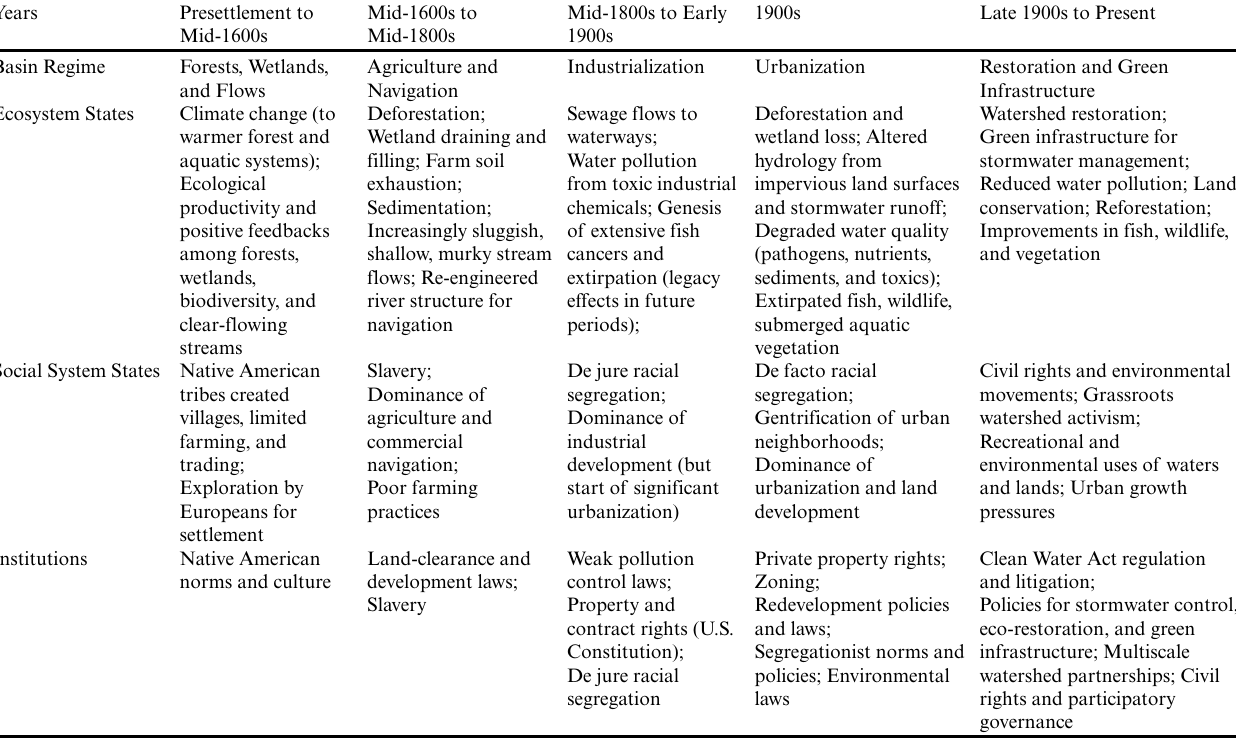
Table 3 . Social-ecological regimes in the Anacostia River Basin. A small watershed in the humid urban-suburban areas of Washington, D.C. and Maryland, the Anacostia River basin has transitioned from biologically rich natural ecology prior to European settlement to three periods of ecosystem degradation due to agriculture and navigation, industrialization, and urbanization, to the present regime dominated by restoration and green infrastructure activities, yet still influenced by previous regimes’ legacy effects and continued urban- development pressures. The major drivers of regime shifts from presettlement to the present are the following: (1) societal treatment of the basin’s waters, lands, vegetation, and wildlife as exploitable goods and services for short-term economic benefit (even in the current “green” regime in which improved water quality and restored lands are public goods and services); (2) shifts from weak to strong environmentalist values and activism; (3) changing ways that humans psychologically relate to the basin and its functions; (4) patterns of structural inequality, oppression, and discrimination, and movements to seek social and environmental justice; and (5) changes in governance institutions, including laws, to support and facilitate the dominant social values and policies of the